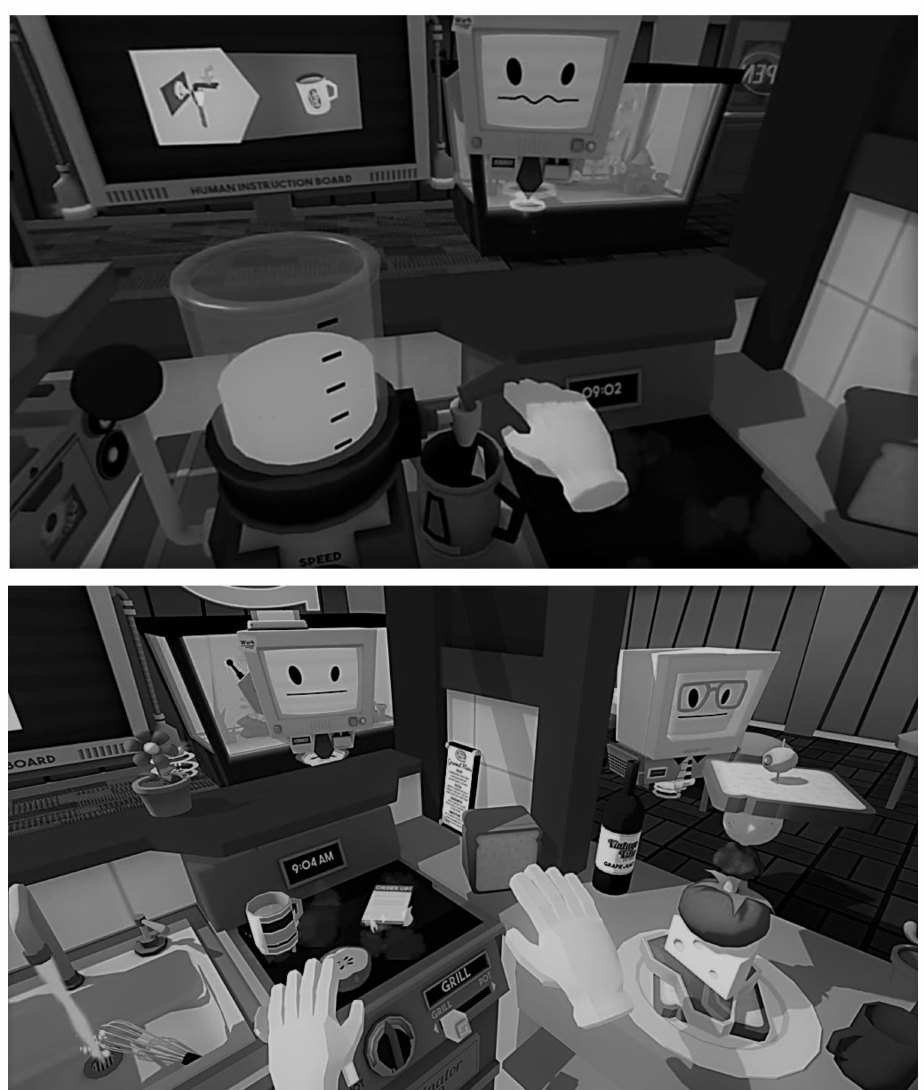
Figure 1. Grayscale images of Job Simulator for the HTC Vive©. Copyright © 2020 by Owlchemy Labs. Visual Memory. The Wechsler Memory Scale–IV (WMS-IV; [31]) is a widely